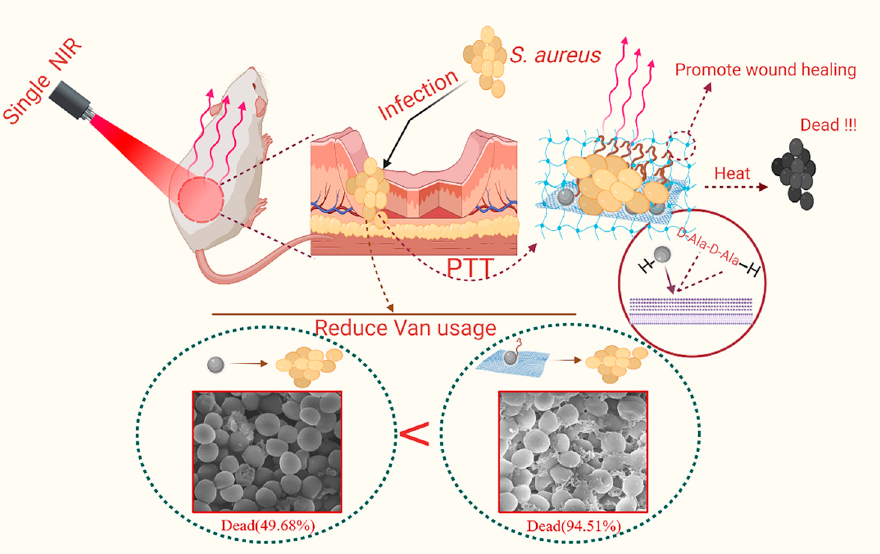
Figure 1. Schematic illustration of the synergism between the two components of MoS 2 and Van in MoS 2 -Van-FITC@CS, which was constructed and applied to wound healing in vivo with their highly efficiently antibacterial properties.